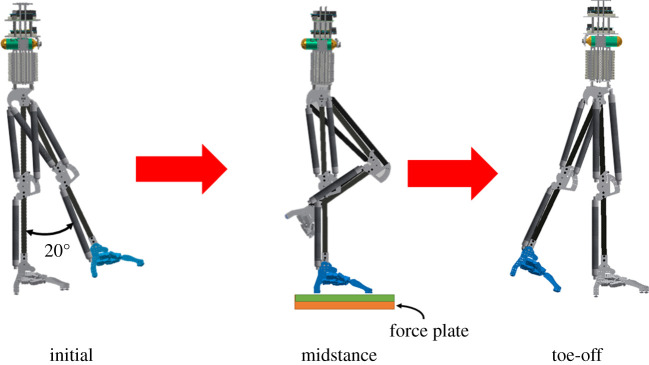
Walking procedure.